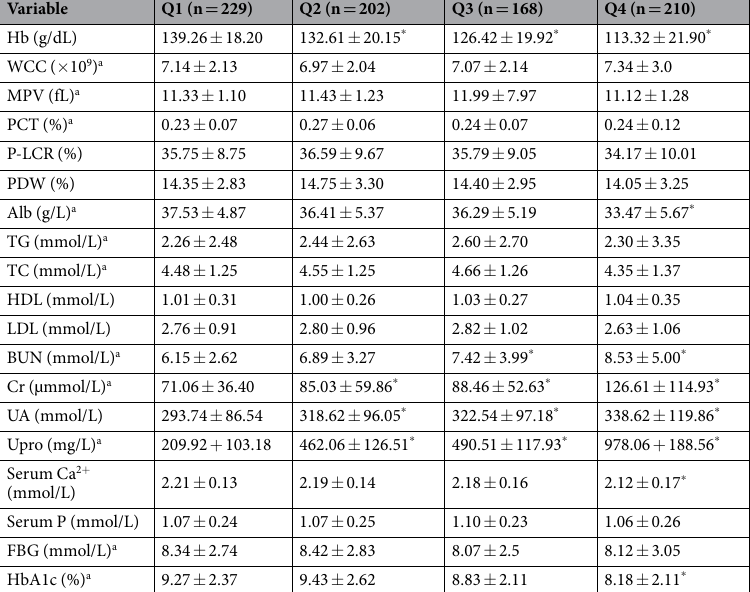
Serum P (mmol/L) 1.07 ± 0.24